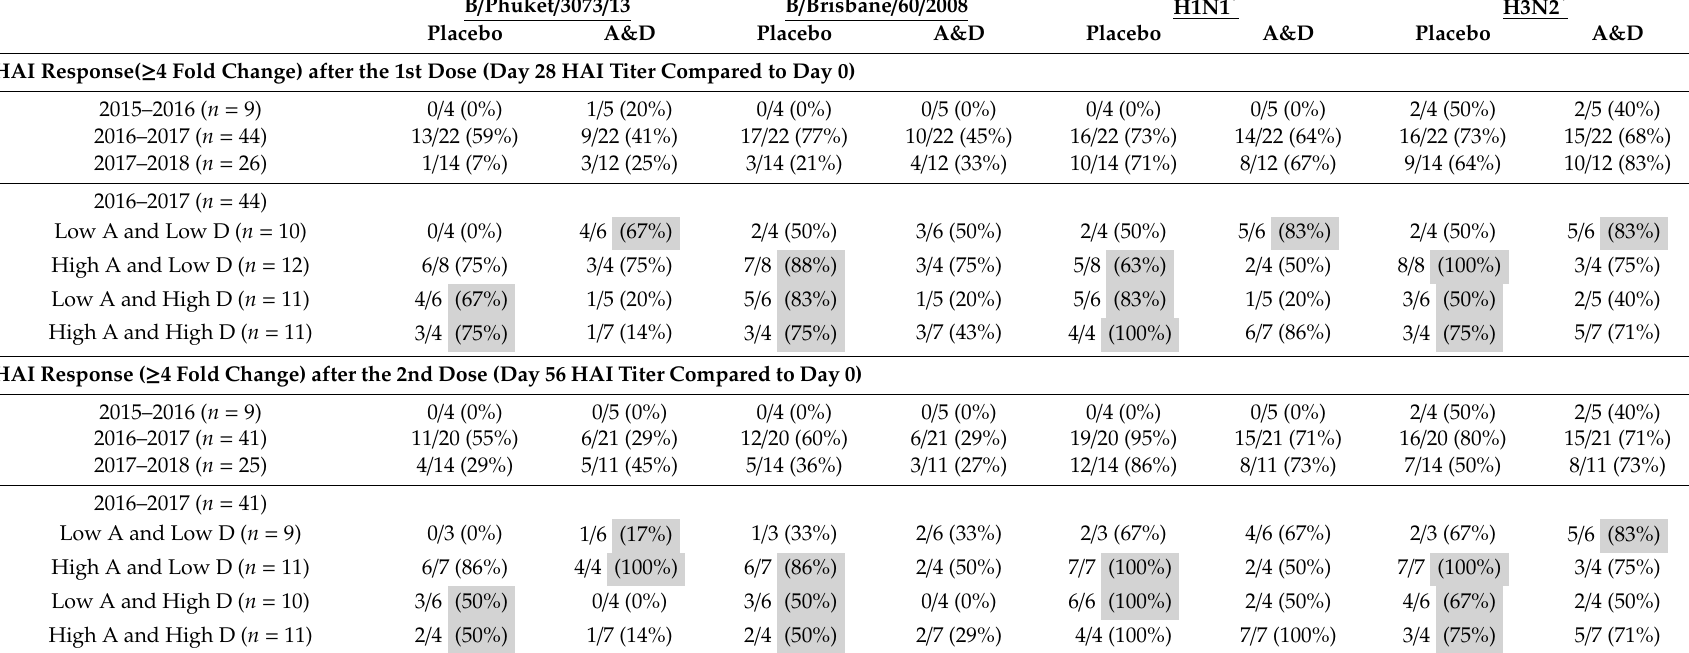
Table 2. HAI response ( ≥ 4 fold change) after the first or second vaccine